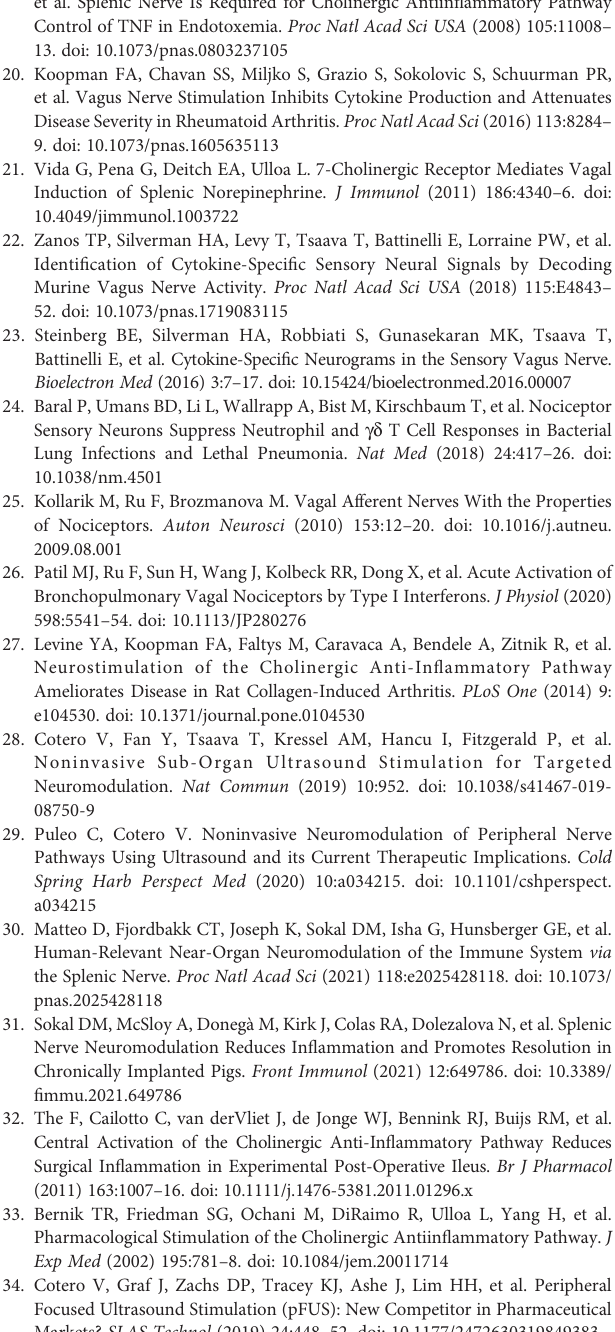
Left lung demonstrates more edema compared to the right lung, which is an indicator of lung injury. (B) Gram stain for gram-positive bacteria in the lungs. The lungs were collected during autopsy and sectioned at 20 um thickness using a cryosection machine. The sections were stained with gram positive stain. The left panels show microscopic images of the right lung. The right panels show images of the left lungs. Left lung images demonstrate more gram-positive bacteria compared to the right lung, which indicates localization of the streptococcus pneumonia infection in the left